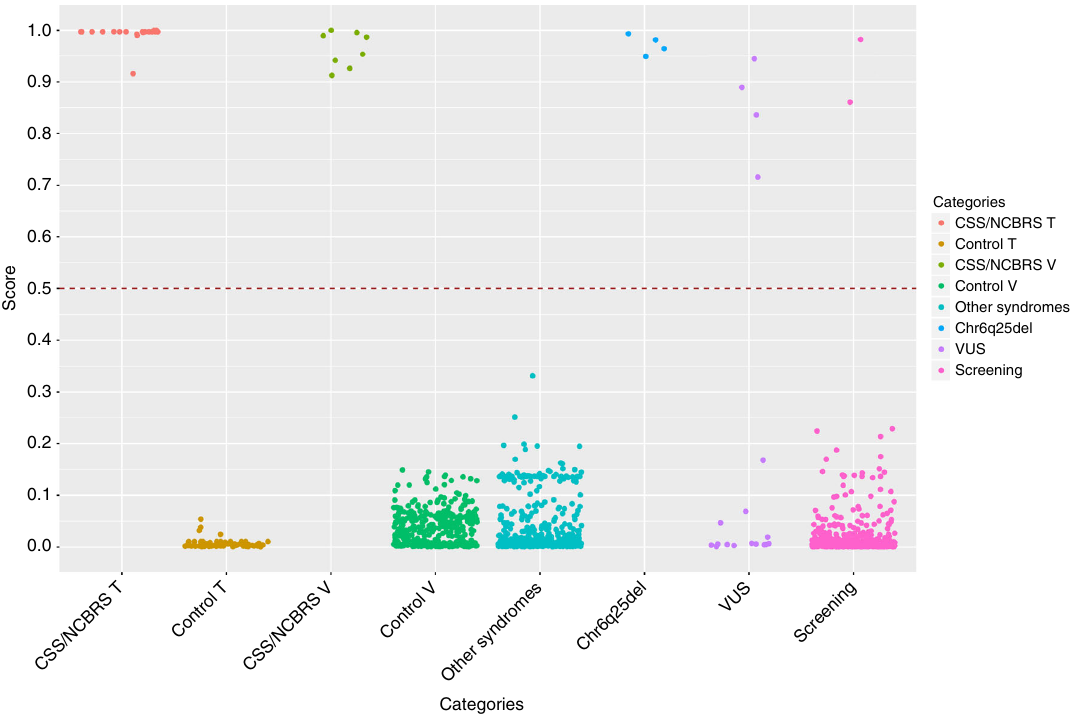
Fig. 8 Scores generated for different subjects by the CSS/NCBRS classi fi cation model. An SVM classi fi er generates scores for every subject as the probability of having a DNA methylation pro fi le similar to what is observed in CSS/NCBRS. The y axis represents scores 0 – 1, with higher scores indicating a higher chance of carrying a methylation pro fi le related to CSS/NCBRS, as strati fi ed on the x axis for different groups of tested subjects. Every point represents a single sample. By default, the SVM classi fi er de fi nes a cut-off of 0.5 for assigning the class (dashed line); however, the vast majority of the tested individuals received a score <0.2 or >0.8. Therefore, to improve visualization, the points are jittered. CSS/NCBRS T: CSS/NCBRS patients from the training set ( n = 21); Control T: control samples used to train the model ( n = 126); CSS/NCBRS V: Samples from the testing set ( n = 8), who were not used for feature selection or model training; Control V: healthy subjects from one internal ( n = 122) and two external cohorts ( n = 48 and 186) used to measure the speci fi city of the model ( n = 356); Other syndromes: subjects diagnosed with various syndromic diseases presenting with DD/ID ( n = 531, details in Methods); Chr6q25del: four patients with interstitial deletions in Chr6q25 (Table 2); VUS: subjects with variants of unknown clinical signi fi cance (VUS) in a CSS/NCBRS-related gene, or with clinical suspicion for CSS/NCBRS (Table 2); Screening: subjects with various presentations of developmental delay and intellectual disability, but with no diagnosis, used for case fi nding ( n = 508). The fi rst two categories represent the classi fi cation of the subjects used to train the algorithm. The second two validate the performance of the classi fi cation model on the testing dataset. In the fi fth category, the model demonstrates the ability to accurately distinguish other DD/ID cases from CSS/NCBRS. All of the Chr6q25del patients (sixth category) are scored high for having a pro fi le related to CSS/NCBRS. The model classi fi es four of the subjects with VUS or clinical suspicion for CSS/NCBRS as a case of CSS/NCBRS and assigns non-CSS/NCBRS status to the rest of the subjects in the seventh category. In the last category, screening of a DD/ID cohort identi fi es Methods Patients and cohorts . Peripheral blood DNA samples from patients with CSS were collected from the Greenwood Genetic Center (Greenwood, SC, USA), with NCBRS were recruited from the Department of Pediatrics at the University of Amsterdam (Amsterdam, The Netherlands). These cases were previously described in detail by Van Houdt et al. 3 . Patients with Chr6q25 deletion syndrome were recruited from Baylor College of Medicine (Houston, TX, USA), previously deli- neated clinically/molecularly in detail by Nagamani et al. 37 . Control subjects were selected from our laboratory reference cohort that is composed of individuals without any abnormal imprinting defects or known diseases that in fl uence the epigenomic pro fi le. This reference cohort was previously preselected from a larger cohort of approximately 1000 individuals across a broad range of age, sex, and ethnicity distribution. The validation cohort, which was later used to measure the speci fi city of our algorithm, is composed of healthy individuals collected from the Greenwood Genetic Center, and two publically available databases obtained from GEO (GSE67705 and GSE104812) 22,23 . Samples from patients with other diagnosed DD/ID conditions were collected from Greenwood Genetic Center and Care4Rare Canada Consortium. Patients with Angelman syndrome, Prader – Willi syndrome, Beckwith – Wiedemann syndrome, Sotos syndrome, Claes – Jensen syndrome, CHARGE syndrome, Kabuki syndrome, ATRX, Cof fi n – Lowry syndrome, Rett syndrome, Fragile X syndrome, autism spectrum disorders, and RASopathies were recruited from the Greenwood Genetic Center. Peripheral blood DNA samples from patients with autosomal